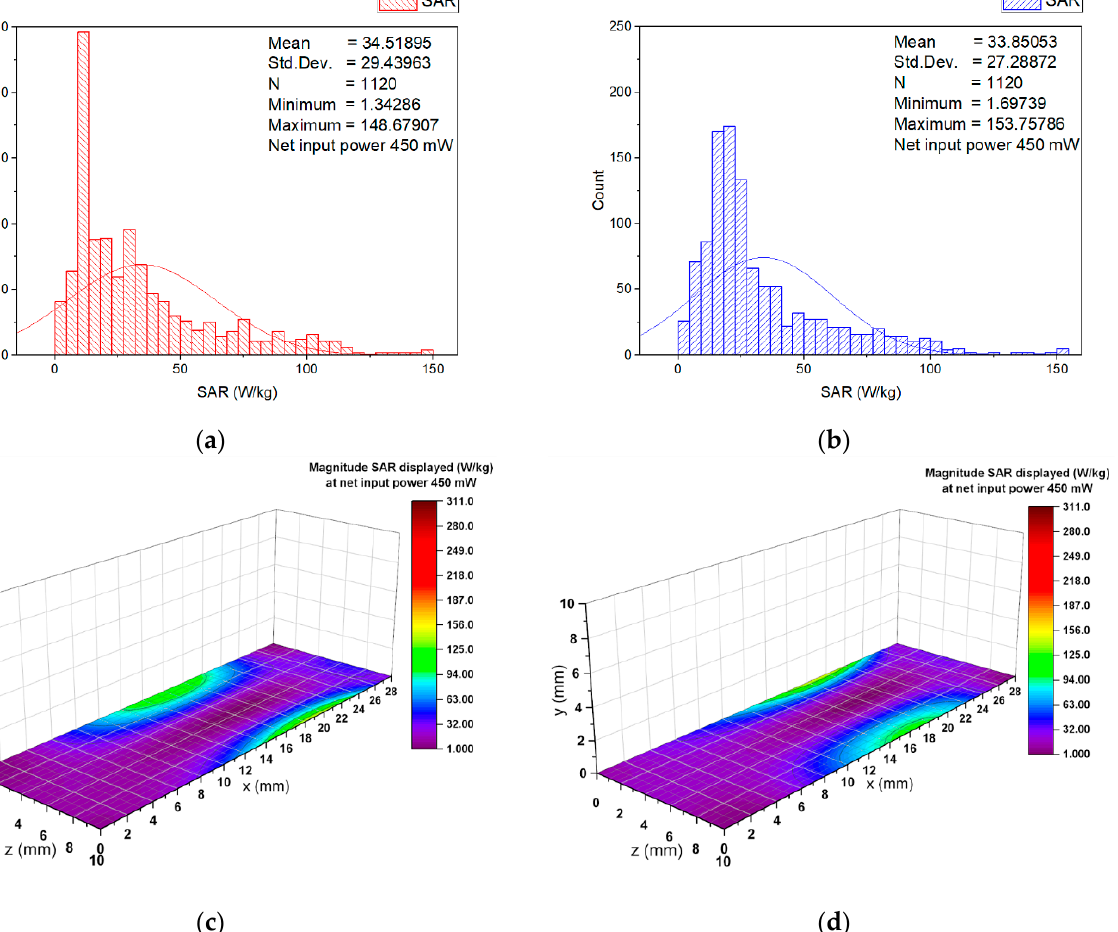
Figure 7. Histograms and descriptive statistics of SAR distribution at net input power of 450 mW for the erythrocyte suspensions in the layer at the bottom of ( a ) left cuvette; ( b ) right cuvette; ( c ) left cuvette color-scale visualization of the SAR distribution; ( d ) right cuvette color-scale visualization of the SAR distribution.